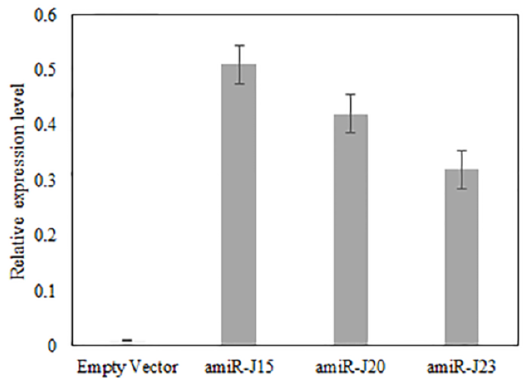
Figure 5. The stem-loop RT-qPCR confirmed the expression of amiR-J15, amiR-J20, and amiR-23 in the hairy roots but not in the hairy roots with empty vector. All three amiRNAs were not detected in the empty vector. Error bars represent the standard error of the mean for three experiments and three biological replicates per experiment, with experiment treated as a random effect.